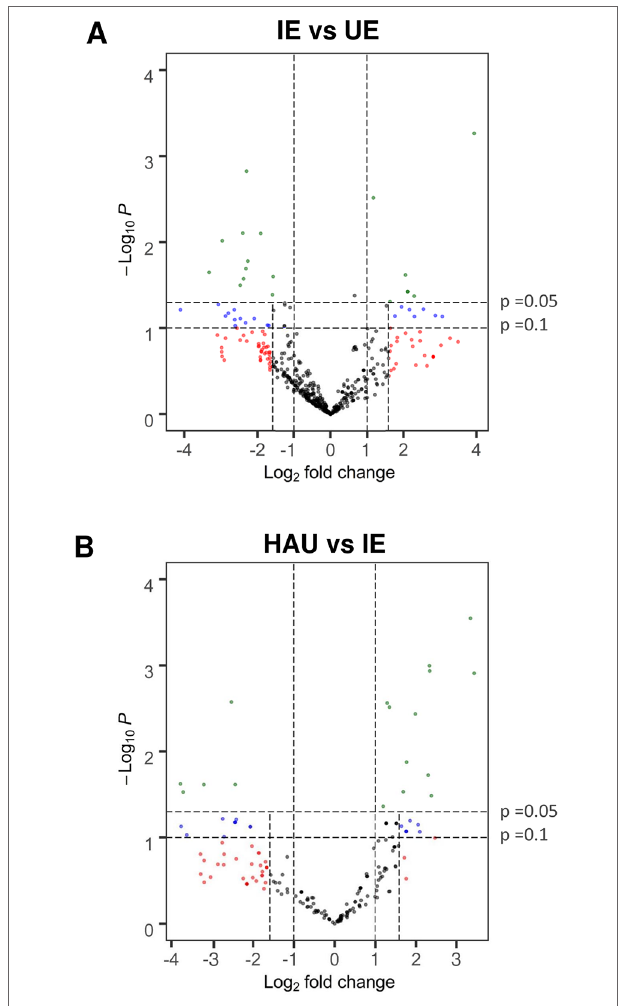
FIGURE 3 | Volcano plot showing relative protein abundance calculated as ratios of normalized spectral count for proteins identified in both (A) , IE and UE, and (B) , HAU and IE; with identification in at least three replicates of either set. A t -test was performed on normalized spectral count values for each protein comparison. Proteins with a P value ≤0.1 and a log 2 fold change ≥1.585 (more than three-fold change), and proteins with a P value ≤0.05 and a log 2 fold change ≥1 (more than two-fold change) were considered differentially abundant. Proteins that were exclusive to either IE, UE, or HAU are not included. IE, infected epidermis; UE, uninfected epidermis; HAU, haustoria-enriched